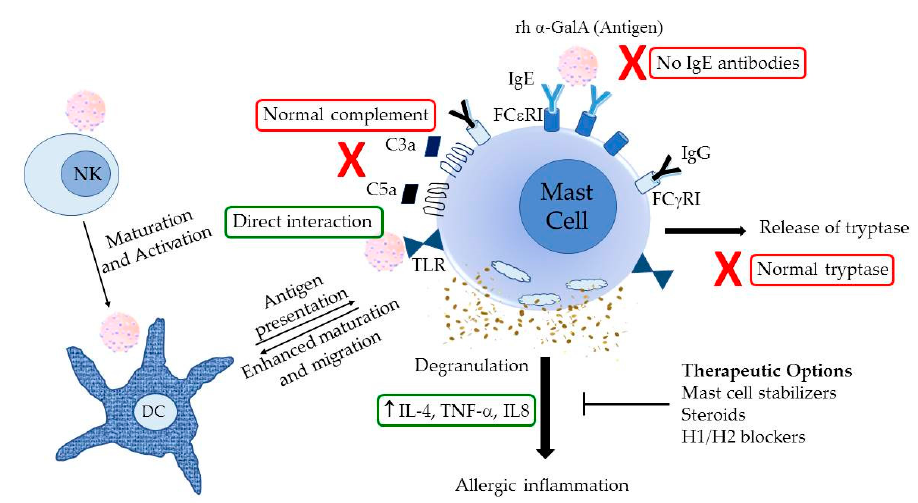
Figure 4. Possible mechanism of mast cell activation in IRRs in Fabry disease patients. NK, Natural killer cells; DCs, dendritic cells; TLR, toll-like receptor; Ig, immunoglobulin; rh α -GalA, recombinant human α -galactosidase A (agalsidase); IL, interleukin; TNF, tumor necrosis factor.